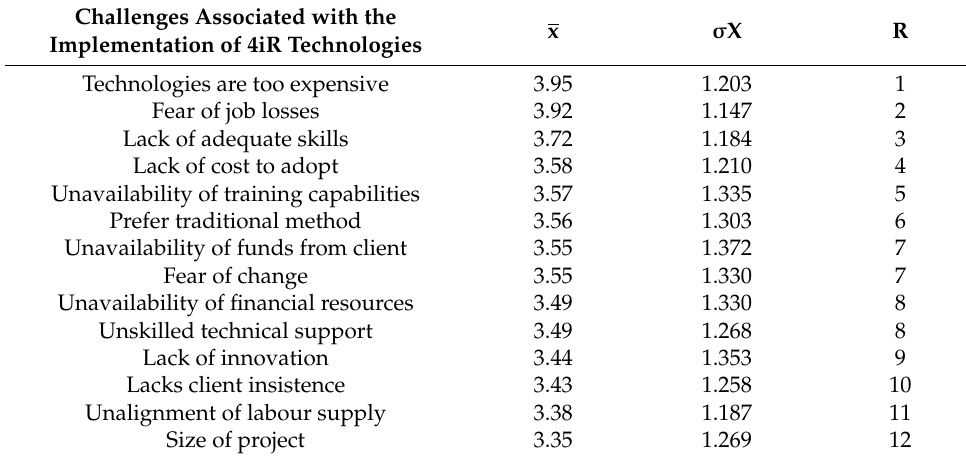
Table 6. Implementing